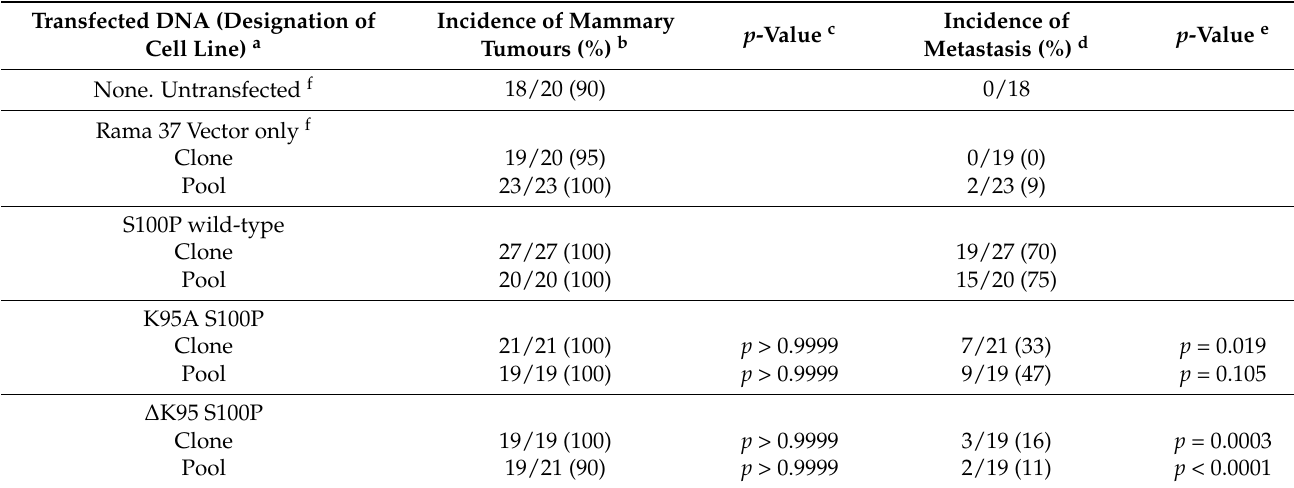
Table 1. Incidences of tumours and